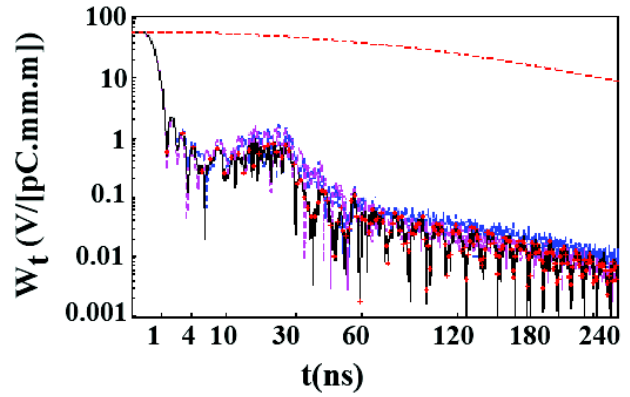
FIG. 6. (Color) . Individual structures are indicated by the ma- genta and blue dashed curves. Also shown is the summation of both wakefields by the black line. The red dots indicate the 1.4 ns locations where the bunches are located in an NLC-like design. The red dashed line indicates how the wakefield damps from Cu losses